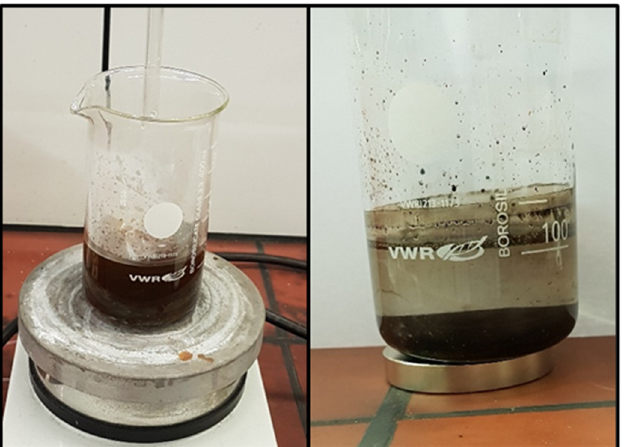
Figure A1. Produced magnetite particles from the bottom-up process ( left ). The same vessel on a strong neodymium magnet ( right ).